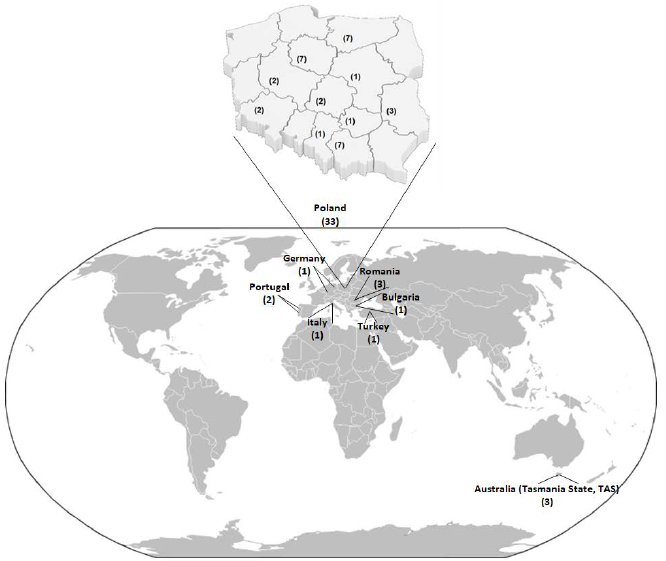
Figure 7. Map of distribution of honey samples in Poland and other countries of the world, including the number of samples.